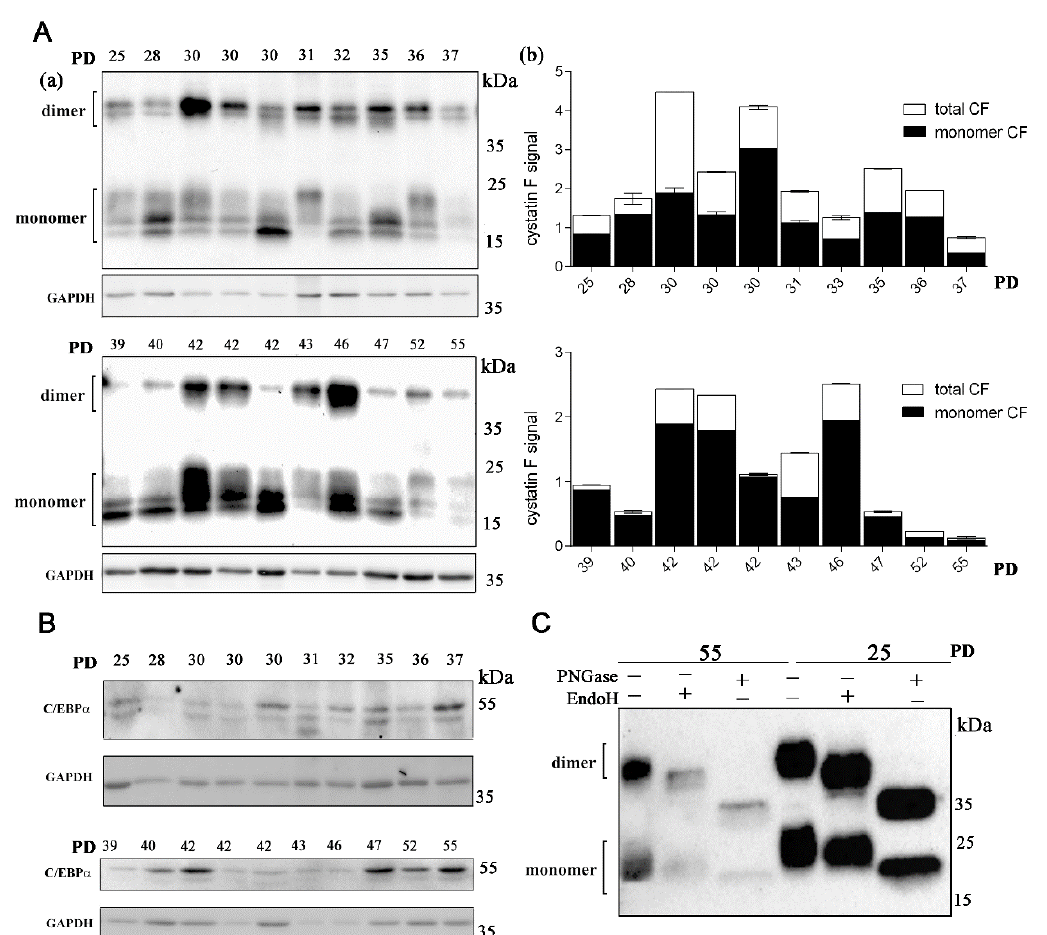
Figure 1. Cystatin F is expressed in long-term cultured CD4+ T cells. ( A ) Western blot analysis and cystatin F immunode- tection in cell lysates of CD4+ T-cell clones ( a ). Representative Western blot out of two experiments and quantification for cystatin F signal. The data are represented mean and standard error of means (SEM). Quantification of the Western blot results shows total and monomeric cystatin F signal. GAPDH staining was used to show equivalent protein loading. Quantification was performed using Image Lab Software using GAPDH signal for normalization ( b ). ( B ) Western blot analysis and C/EBP α immunodetection in cell lysates of CD4+ T-cell clones. GAPDH staining was used to show equivalent protein loading. ( C ) Western blot analysis and cystatin F immunodetection in cell lysates of old (55) and young (25) T-cell clones after treatment with Peptide: N -glycosidase F (PNGase) and endoglycosidase H (EndoH).